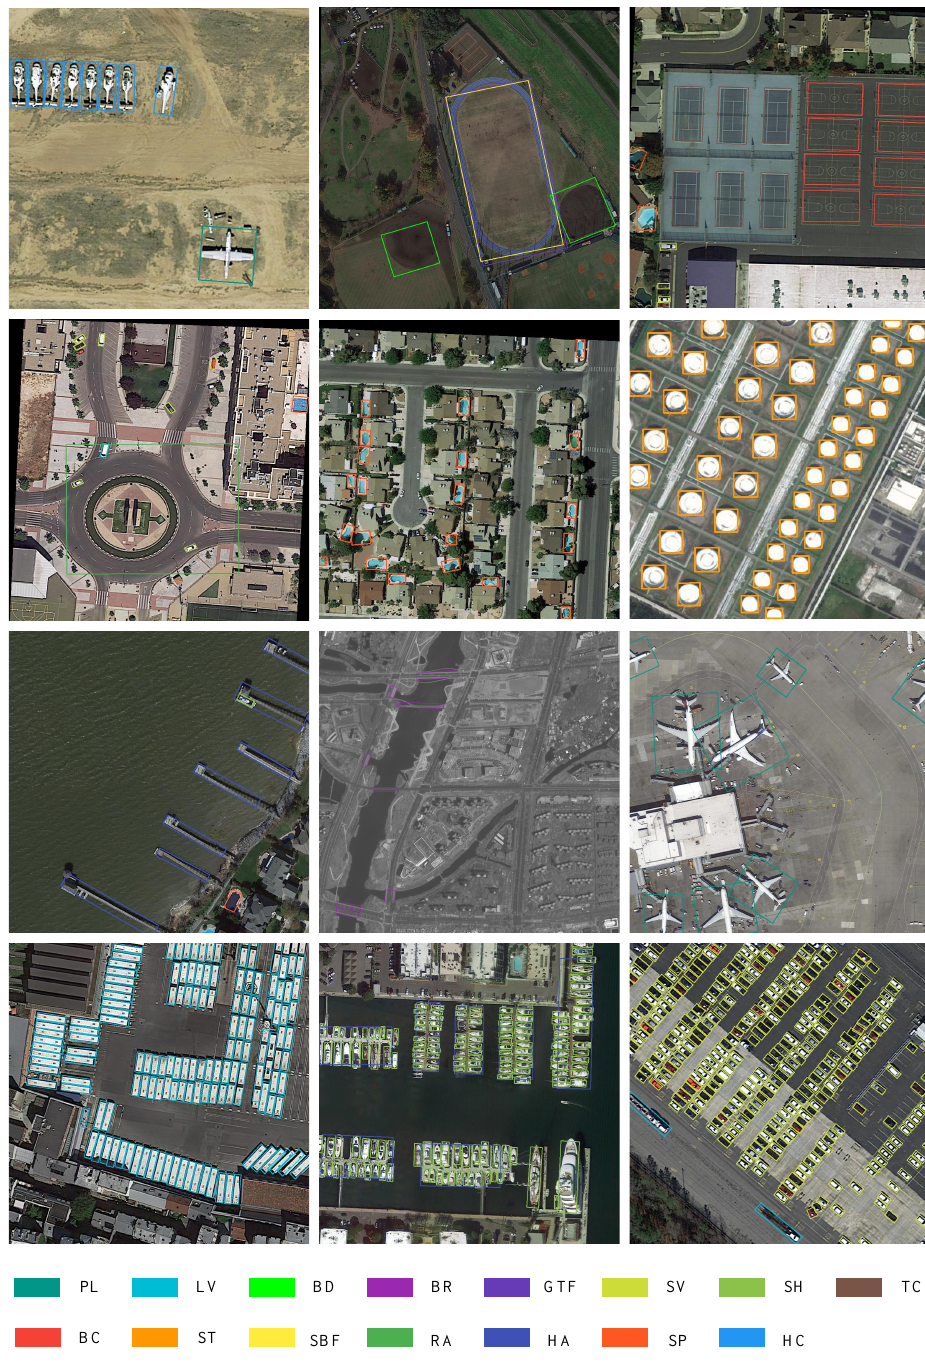
Figure 10. Visualization of some detection results on DOTA